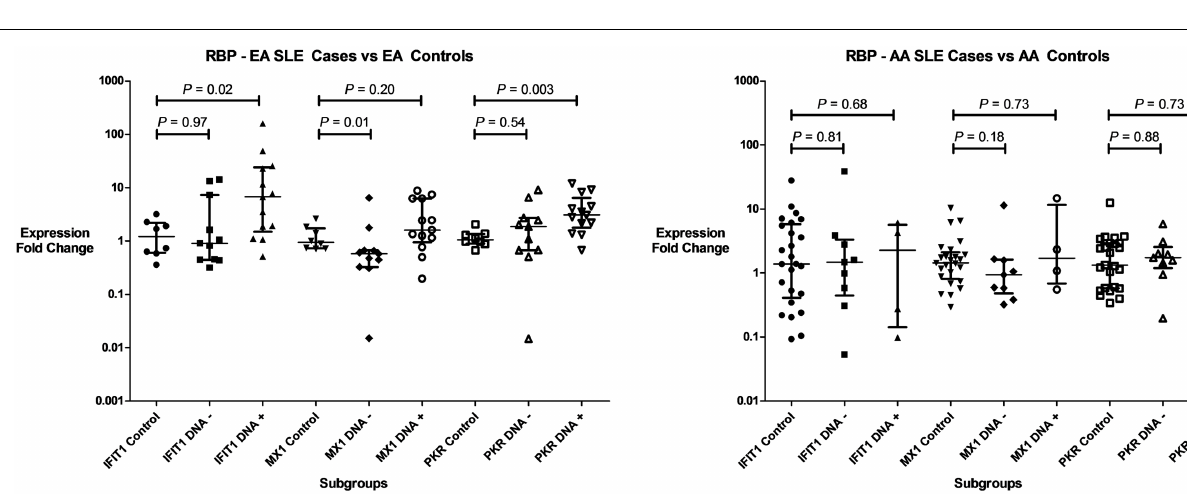
FIGURE 2 |Type I IFN-induced gene expression in SLE patient subgroups and controls . Expression of three genes (IFIT1, MX1, and PKR) are shown in both patients with anti-RNA-binding protein antibodies (RBP + ), and those